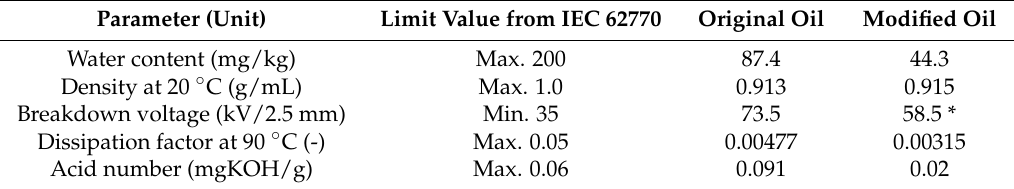
Table 5. Comparison of the characteristic parameters of the ENVITRAFOL with the limit values according to IEC 62770.